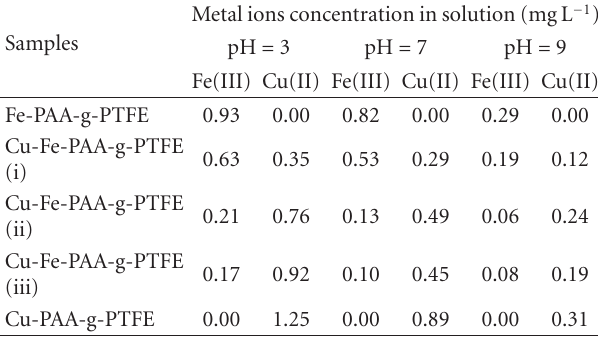
Table 3: Impact of Cu/Fe molar ratio on leaching of metal ions from Cu-Fe bimetallic PTFE fiber complexes.